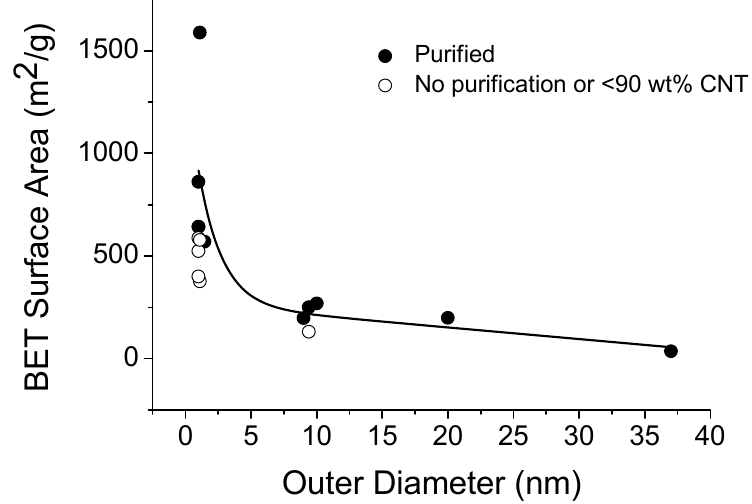
Figure 7. Dependence of carbon nanotube specific surface area on nanotube outer diameter. The data was taken from the literature and supplemented with our own measurements (see Table S1, supplementary materials, for further details and references for the data). The open circles represent results for nanotubes reported to have high impurity